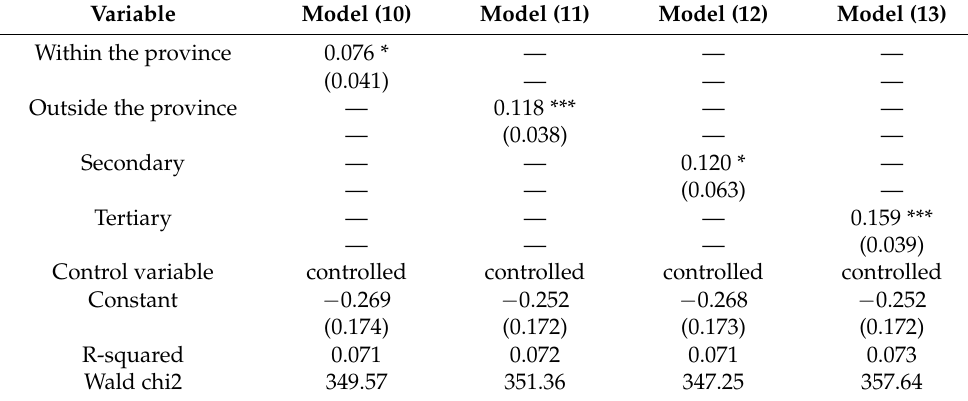
Table 7. Heterogeneity of non-farm employment